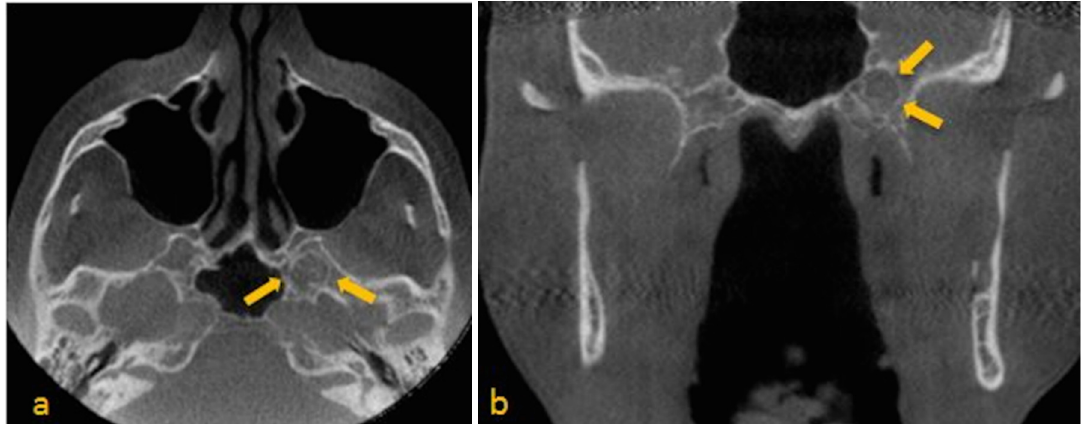
Figure 3. ( a ) Para-axial; ( b ) Paracoronal CBCT images show mixed density area in the left greater wing of the sphenoid adjacent to the sphenoid sinus. Note curvilinear calcifications within this area. (a) Para-axial view, shows suspected disruption of the vidian canal on the left side; (b) Paracoronal view, depicts vidian canal wider than the right side.